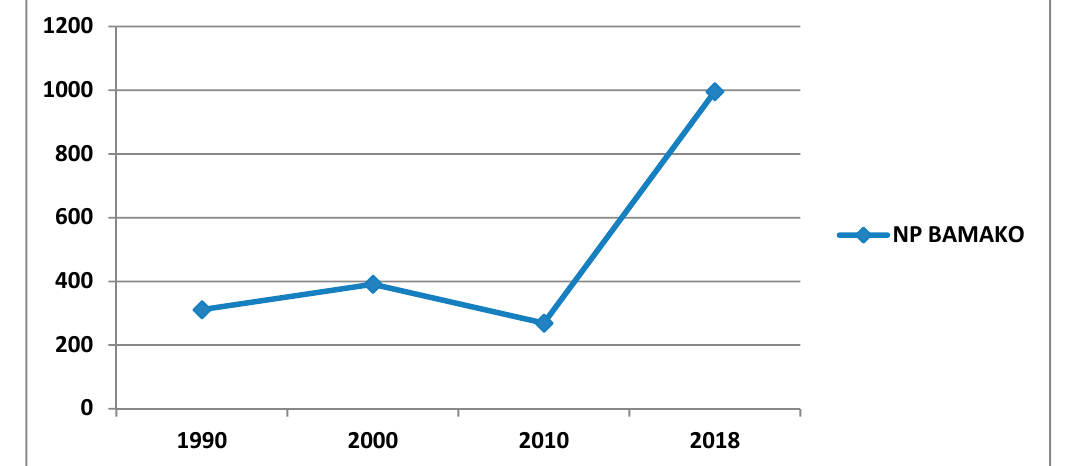
Figure 8. Curve of NP for built-up in Bamako district from 1990 to 2018.